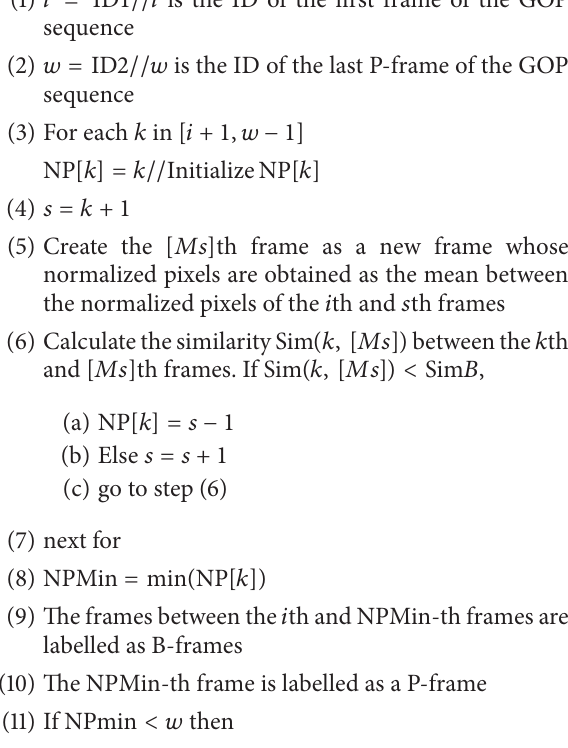
Algorithm 2. Pseudo-code for determining type of